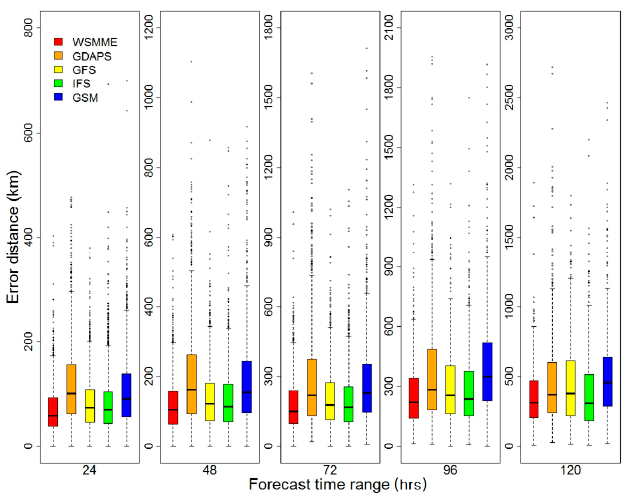
Figure 3. Boxplots for track forecast errors from WSMME and models during 2012–2015.